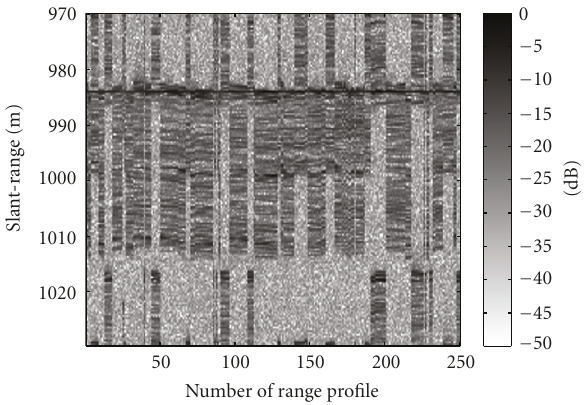
Figure 6: Range profiles for the simulated example after applying the peak tracking method. Note that the target scintillation phenomenon makes this approach fail.